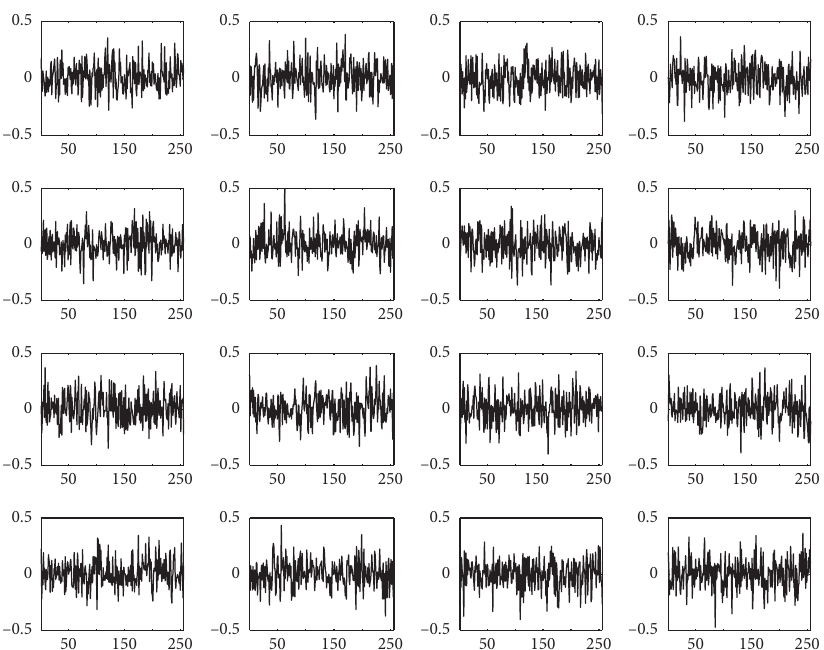
Figure 13: Part of the learned dictionary atoms by using the IKSVD method on the signal as shown in Figure